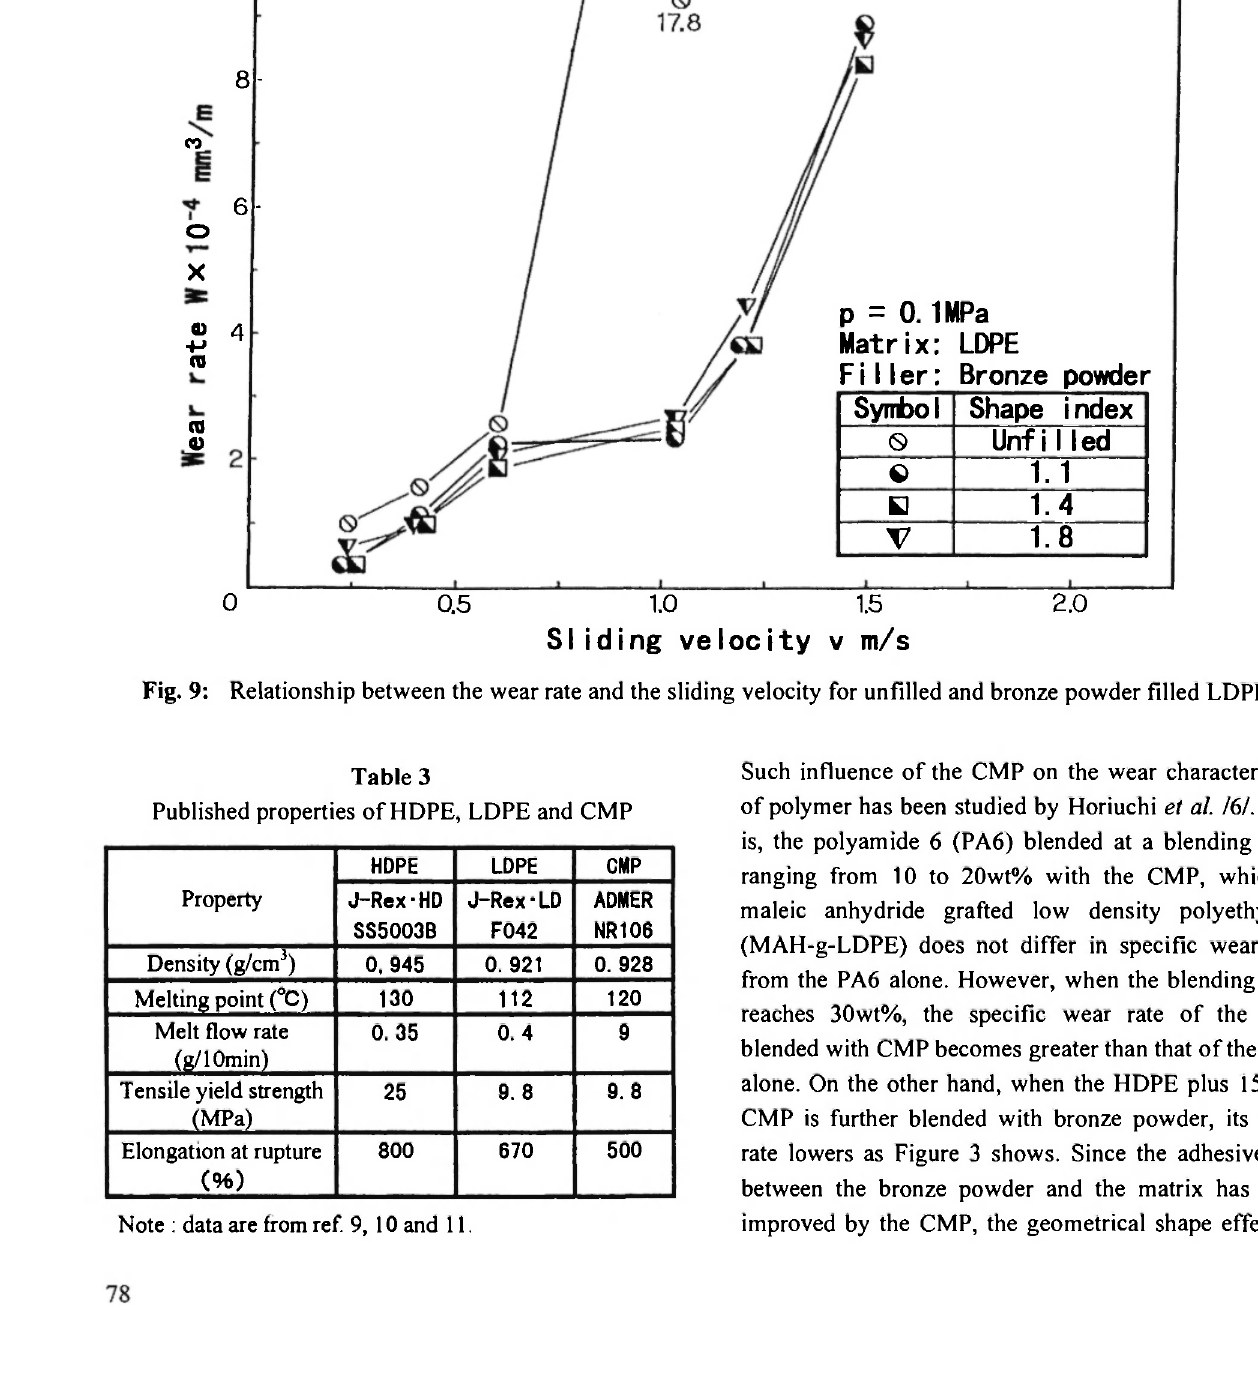
Published properties of HDPE, LDPE and